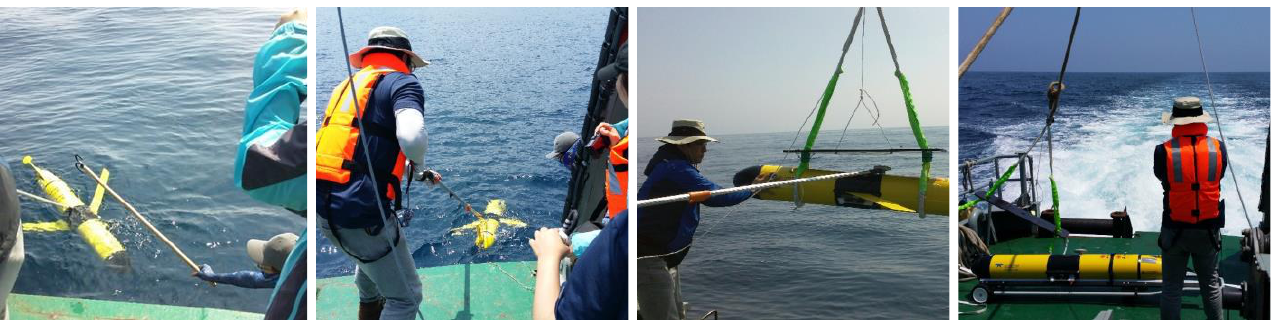
Figure 1. The manual recovery of underwater gliders.